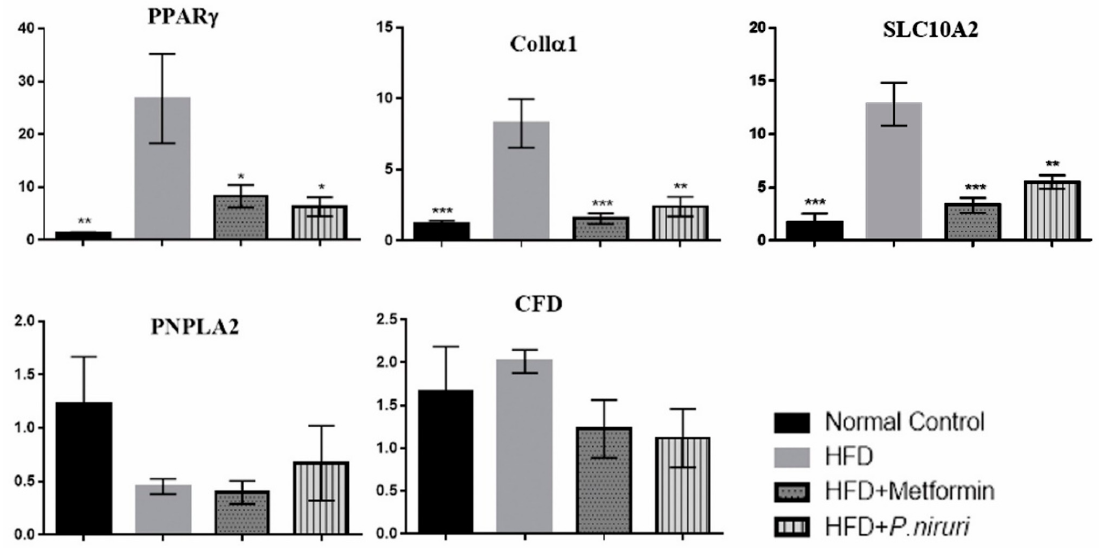
Figure 3. Real-time PCR analysis shows the relative normalized gene expression of peroxisomal proliferator-activated receptor- γ (PPAR γ ), collagen type alpha 1 (Coll α 1) and sodium/bile acid cotransporter member 2 (SLC10A2) between all experimental groups. All values are expressed as mean fold changes of mRNA ± SEM, * p < 0.05 vs. HFD group, ** p < 0.01 vs. HFD group, *** p < 0.001 vs. HFD group. HFD